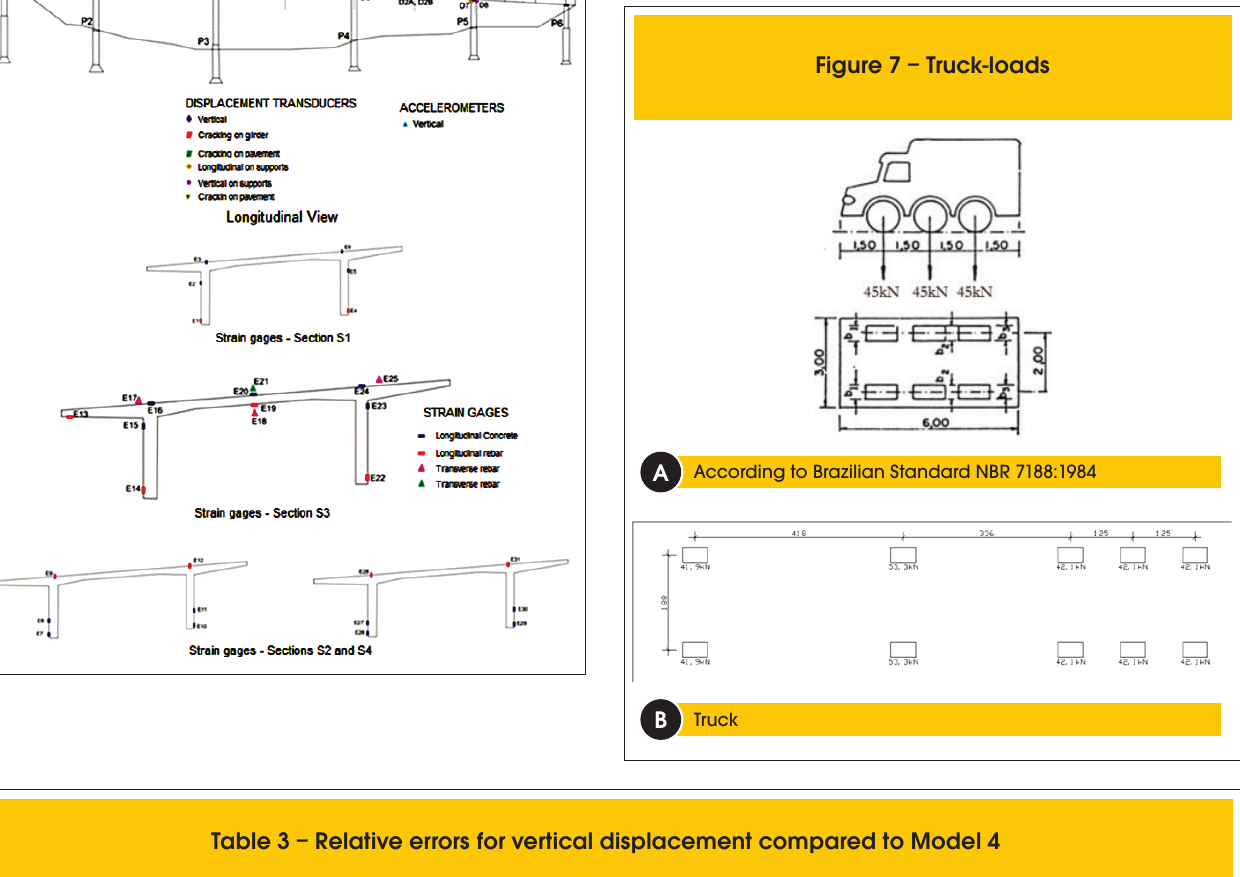
Table 3 – Relative errors for vertical displacement compared to Model 4